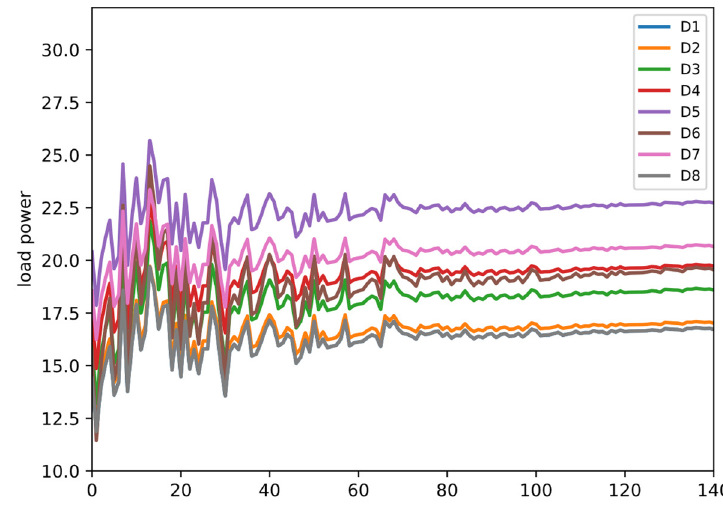
Figure 9. Load varies with market clearing price.